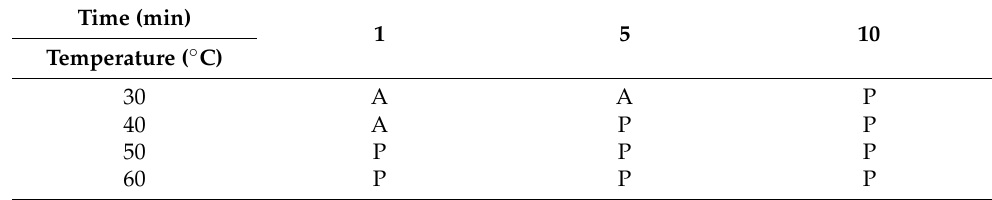
Table 1. Color appearance in the 5 mg CT sample in the 0.1 mol/L NaOH solution under the influence